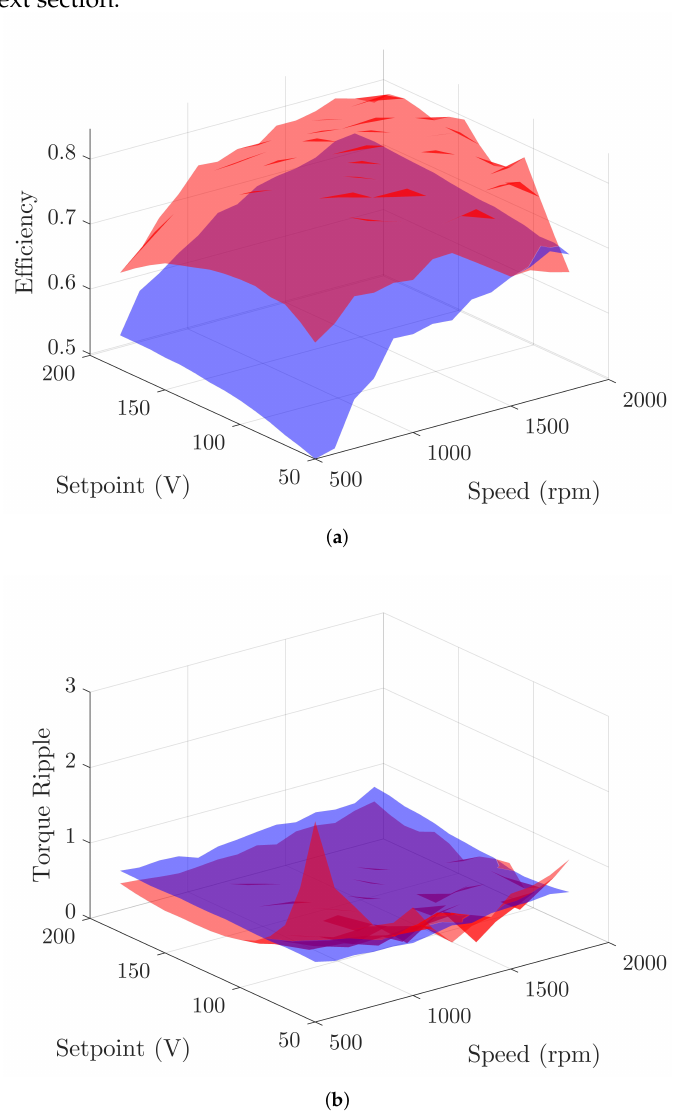
Figure 12. Efficiency and torque ripple surfaces for each implemented PID controller (blue surface: PID controller acting on the excitation voltage, red surface: PID controller acting on the turn-off angle): ( a ) SRG efficiency and ( b ) SRG torque